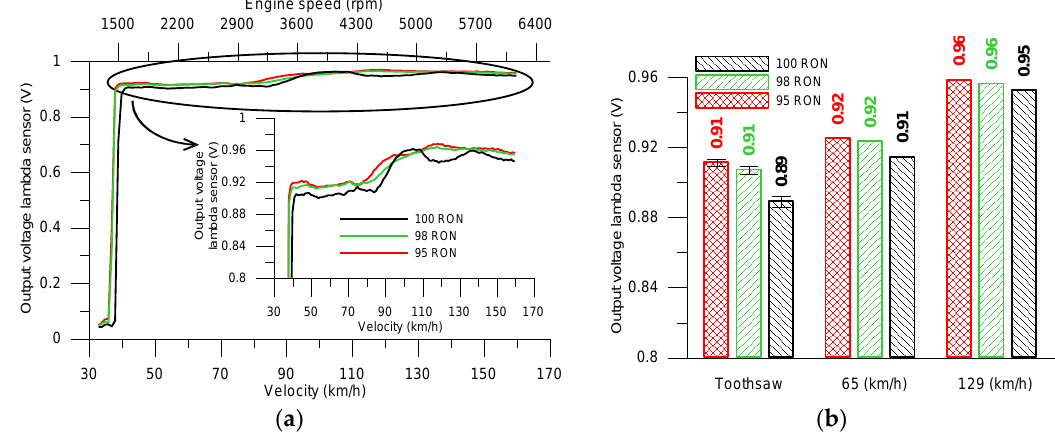
Figure 5. ( a ) Lambda values along the toothsaw, ( b ) average lambda values along toothsaw and steady-state modes.